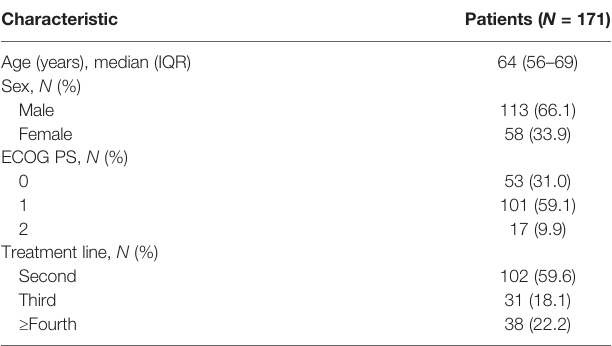
TABLE 2 | Immune-related adverse events within 6 weeks of initiating nivolumab treatment. Event Patients ( N = 171)